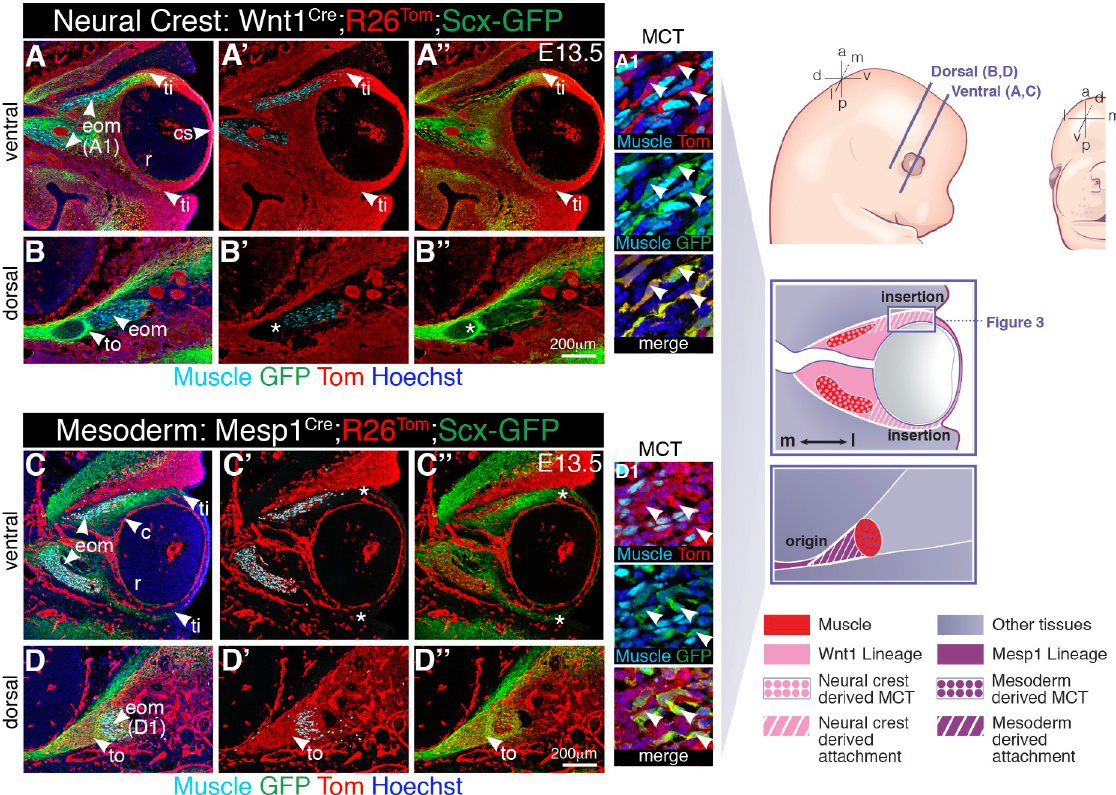
Fig 1. Lineage contributions to the EOM functional unit. (A-B”) Neural crest ( Tg : Wnt1 Cre ;R26 Tom ) and (C-D”) mesodermal ( Mesp1 Cre ; R26 Tom ) lineage contributions to the periocular region of E13.5 embryos, combined with immunostaining for tdTomato (Tom), GFP ( Tg : Scx-GFP reporter), and muscle (PAX7/MYOD/MYOG, myogenic markers). Coronal sections at ventral ( A-A”, C-C” ) and dorsal ( B-B”, D-D” ) levels. Asterisks in B’,B” denote Tom negativity at the tendon origin. Asterisks in C’,C” denote Tom negativity at the tendon insertion site. ( A1, D1 ) High-magnification views of muscle areas in panels A and D . ( n = 3 per condition). a, anterior; c, choroid; cs, corneal stroma; d, dorsal; E, embryonic day; eom, extraocular muscle; l, lateral; m, medial; MCT, muscle connective tissue; p, posterior; r, retina; ti, tendon insertion; to, tendon origin; v,